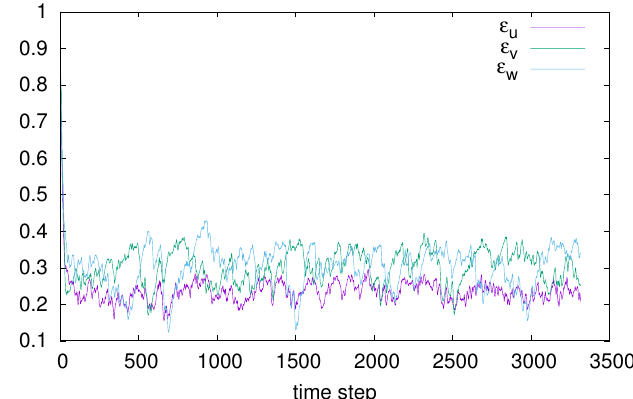
Figure 11. PID control error for the three velocity components evaluated by Equation (15) and plotted as a function of time.